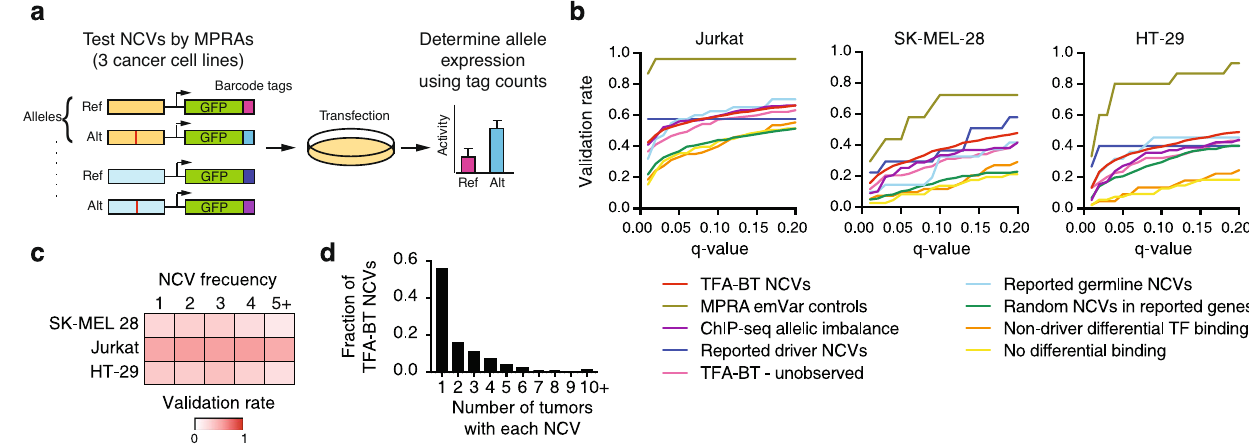
Fig. 2 | TBA-BT NCVs alter transcriptional activity. a Overview of the evaluation of NCVs by massively parallel reporter assays (MPRAs). b Fraction of NCVs from each test set within MPRA active regions that show expression allelic skew at dif- ferent q-value thresholds in Jurkat, SK-MEL-28, and HT-29 cells. c Heatmap of